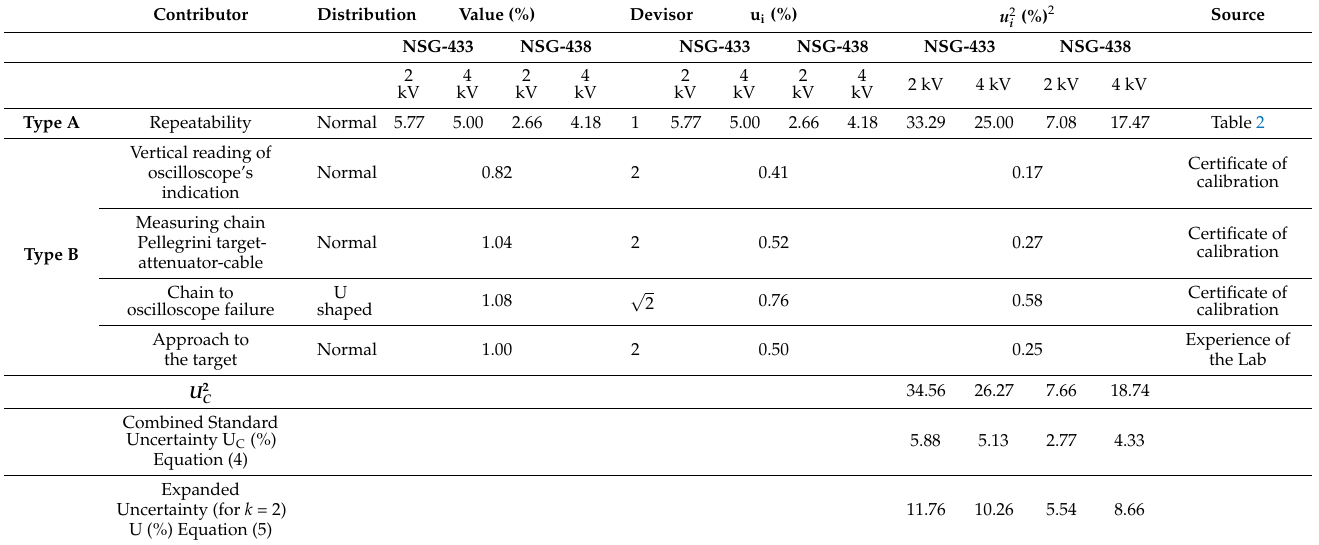
Table 3. Combined Standard Uncertainty for I p .